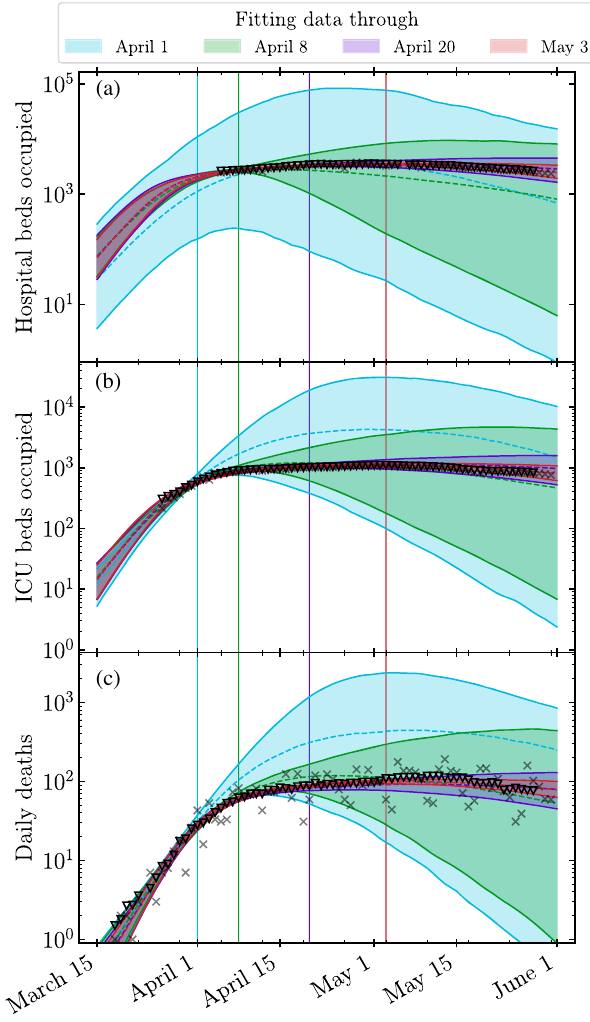
FIG. 3. Robustness of simulations for the COVID-19 epidemic in Illinois, evaluated by comparing 95.6% confidence regions of predictions for parameter inference calibrated to data through April 1 (light blue), April 8 (green), April 20 (purple), and May 3, 2020 (red). The panels depict the number of hospital beds occupied (a), the number of ICU beds occupied (b), and the total daily deaths (c). In each panel, triangles depict the data smoothed by a 7-day rolling average, and grey crosses are the actual